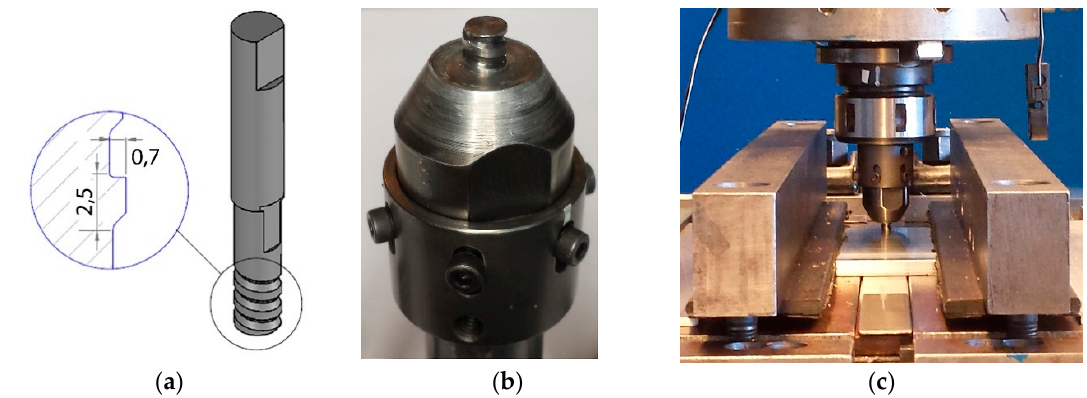
Figure 3. Technological conditions used in the application of the FSC process to the AA5083-H111 plate: ( a ) Specifications on probe thread profile (dimensions are in mm); ( b ) An assembled perspective of the FSC-tool, exhibiting the shoulder and probe; ( c ) Clamping apparatus implemented for the production of the FSC samples.